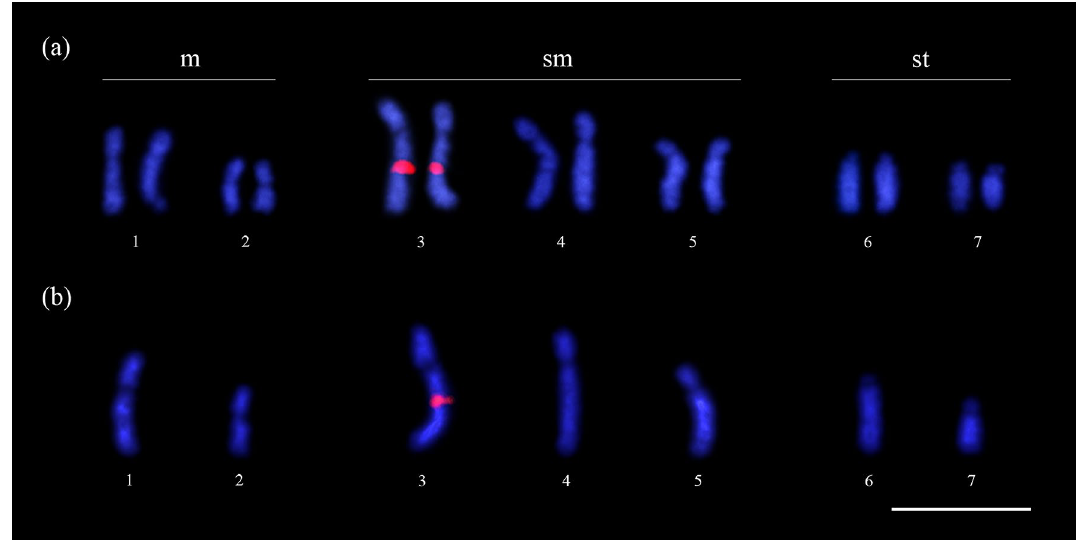
Figure 9. Metaphase chromosomes of Mycocepurus smithii from the sexual population stained with the FISH technique showing the presence of 18S rDNA genes (red regions) in ( a ) female (2n = 14) and ( b ) male (n = 7). Scale bar represents 5 µm.